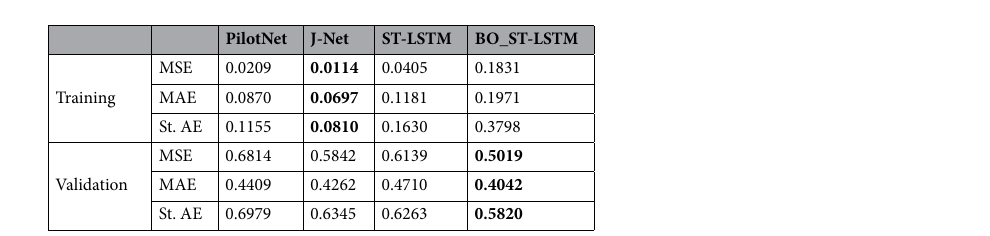
Table 3. Average values of the prediction performance indicators on the training and validation sets for the four architectures. In bold the best value for each indicator.